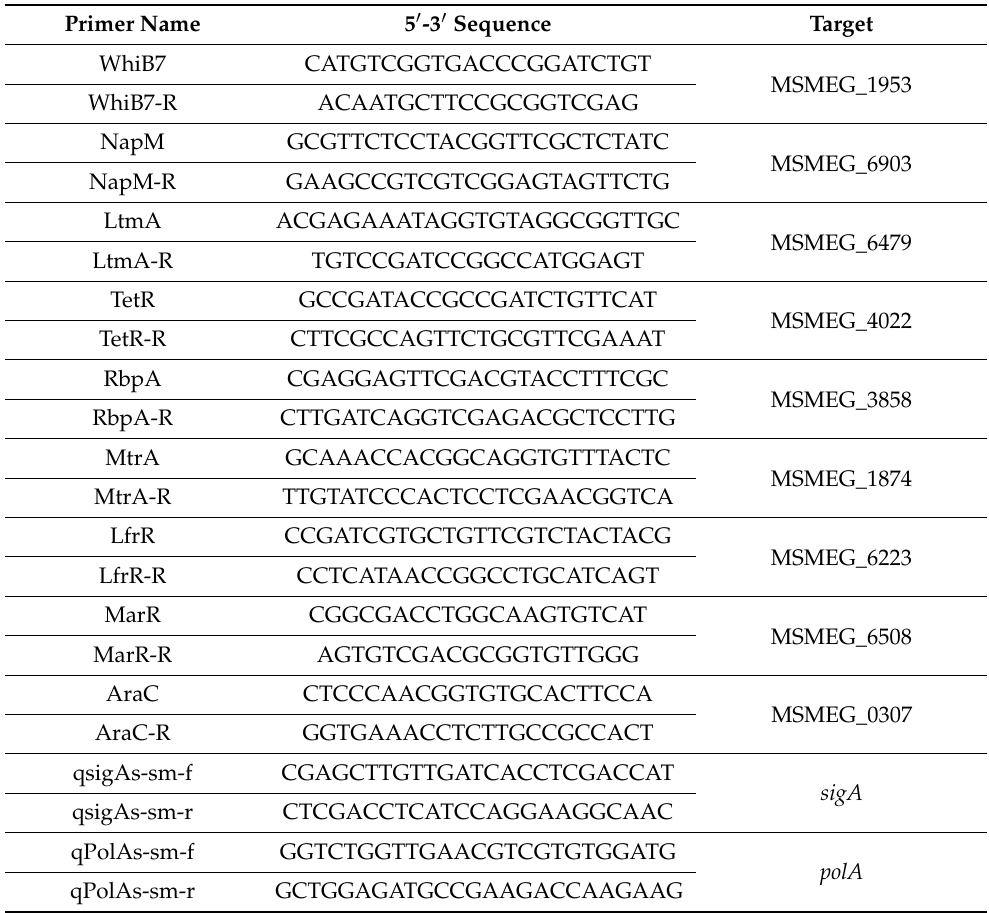
Table A1. List of primers used in the study. Primer